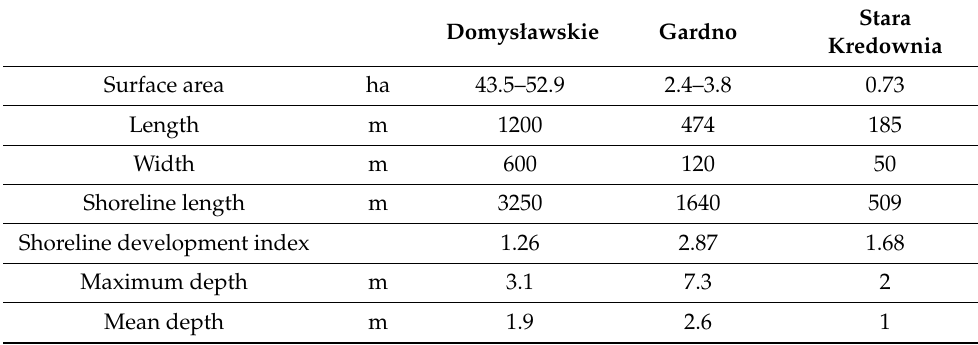
Figure 1. Location of the studied lakes in the Wolin National Park ((a)—Domys ł awskie Lake; (b)— Gardno Lake; (c)—Stara Kredownia). Table 1. Morphometric data of the studied water bodies [11–13]. Data regarding the southern water-covered basin of the Stara Kredownia reservoir are based on our analysis of satellite images.